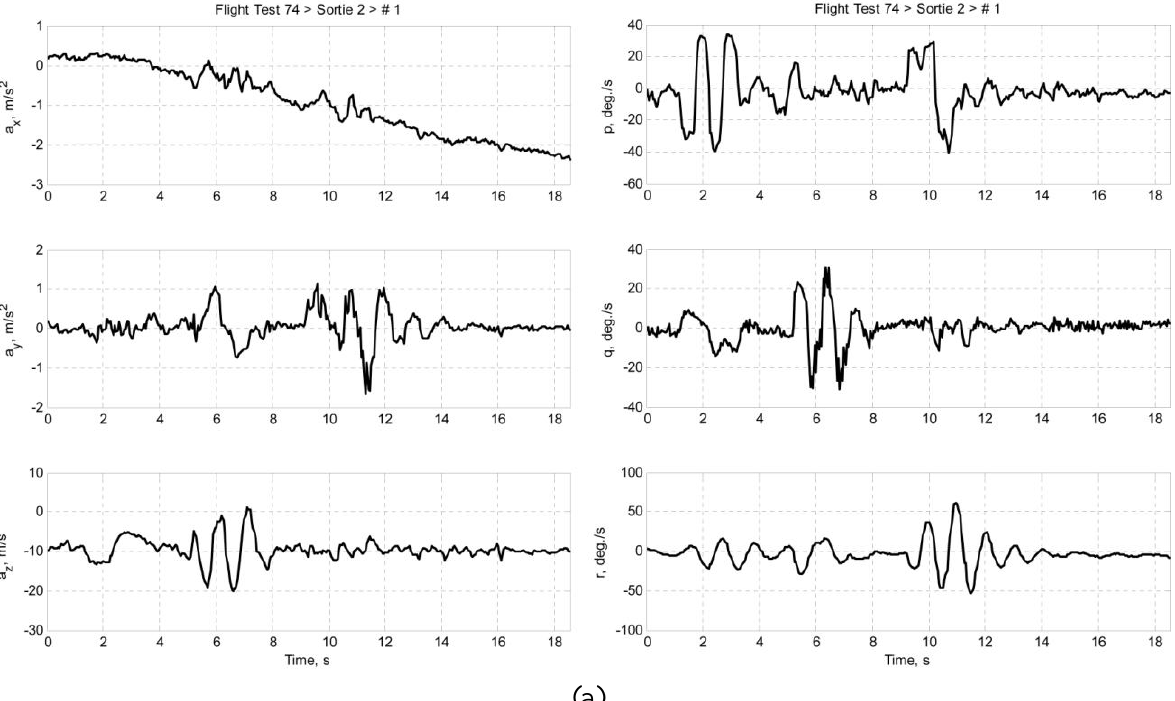
Figure 6. (a) Accelerations and angular rates of ft74srt02run01. (b) Airdata and attitude angles of